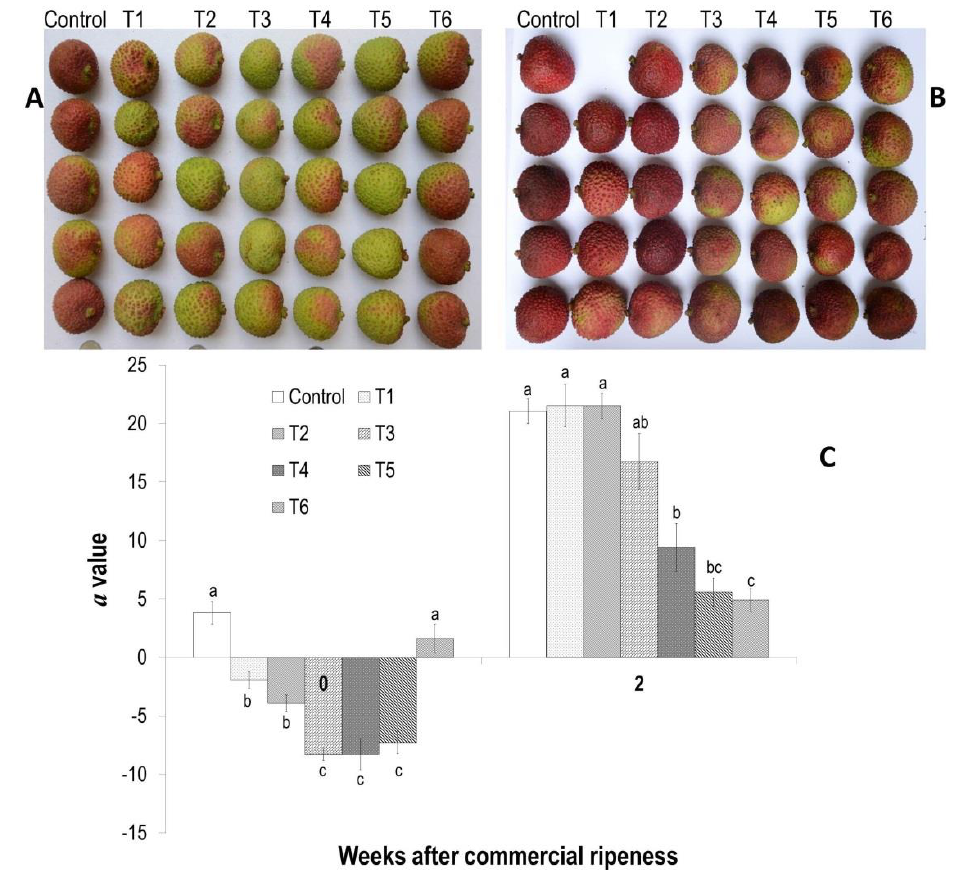
Figure 3. Effect of CPPU treatments at different stages on color and a value as fruit became overripe on tree. ( A ). Fruit appearance at optimal commercial ripeness; ( B ). Fruit appearance at 2 weeks after optimal commercial ripeness; ( C ). Changes in a value. CK represents the control, while T1, T2, T3, T4, T5 and T6 represent spraying 5 mg/L CPPU at 2, 4, 6, 8, 9 and 10 weeks after female bloom, respectively. Different letters indicate significant difference among treatments at the same sampling time at p < 0.05, Duncan’s multiple range test.